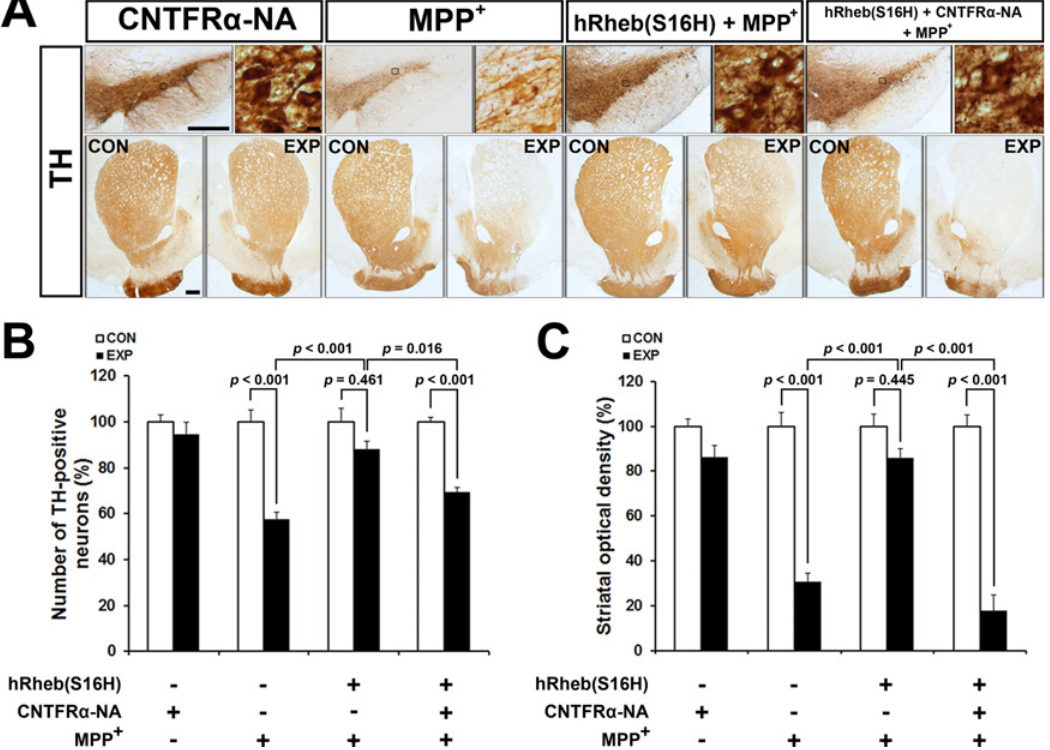
Fig 4. CNTFR α neutralization inhibits the protective effects of the nigrostriatal dopaminergic projection by hRheb(S16H) transduction against MPP + -induced neurotoxicity. (A) Neutralizing antibodies for CNTFR α (CNTFR α -NA) were injected in rats 3 weeks after the intranigral injection of AAV- hRheb(S16H). Following this, rats were injected into the MFB with MPP + . Representative coronal sections of the SN and STR of TH immunoperoxidase staining showed that CNTFR α neutralization attenuated the protective effects induced by hRheb(S16H) against MPP + neurotoxicity. CON, contralateral control side; EXP, ipsilateral injected side. Scale bars represent 500 μ m and 10 μ m in the SN, respectively, and 500 μ m in the STR. (B and C) The quantitative analysis of TH-positive neurons and fibers demonstrated that treatment with neutralizing antibodies for CNTFR α significantly decreased the hRheb(S16H)-induced neuroprotection on the nigrostriatal projection. All values are expressed as a percentage of the results in the ipsilateral SN and STR, respectively, compared with the contralateral controls (One-way ANOVA and Tukey post-hoc analysis; n = 4, each group).